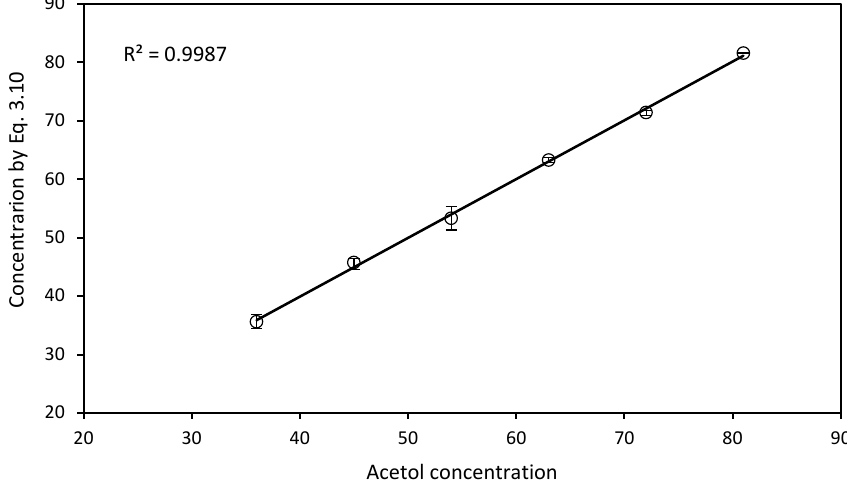
Figure 6. Graph of the real concentrations of acetol versus the estimated ones by Equation (4).